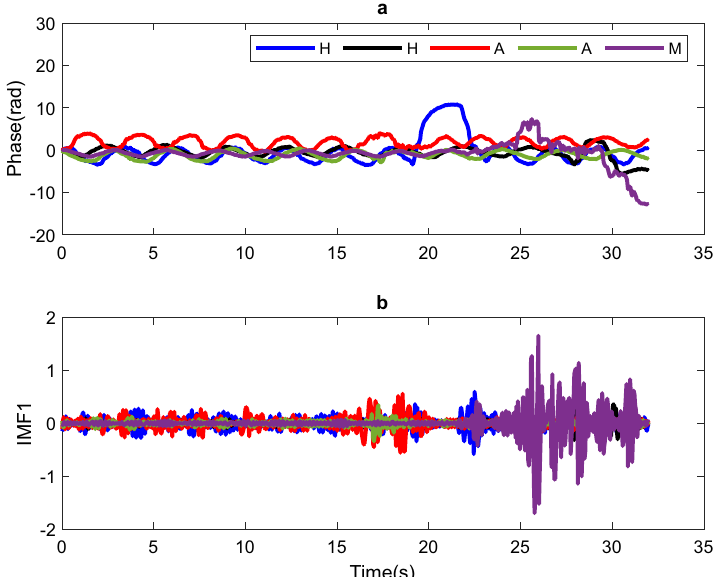
Figure 3. ( a ) Phase signal and ( b ) IMF1 obtained from applying EMD with PUT performing head (H), arm (A) and arms, legs and torso (M) movements.